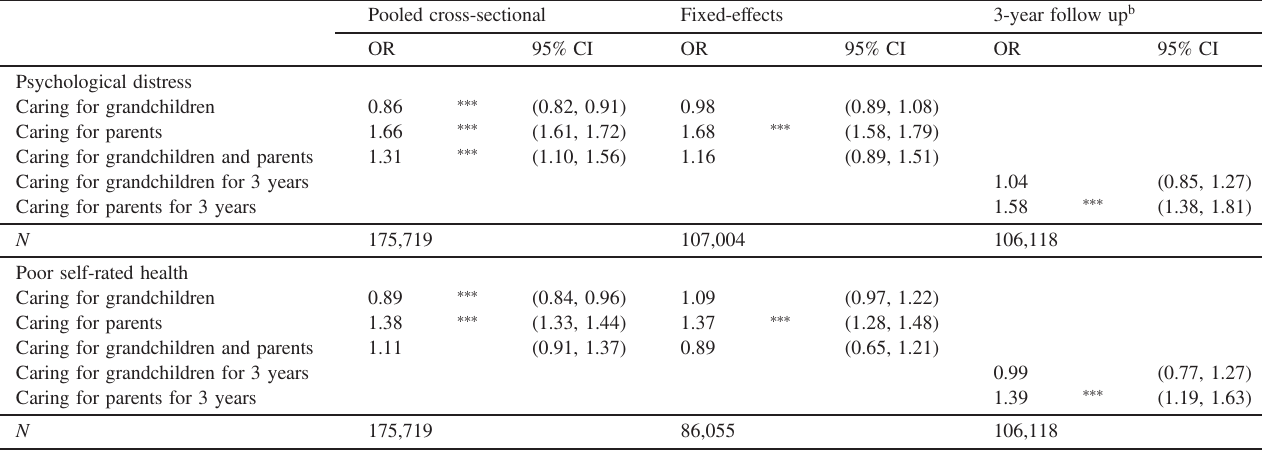
Table 3. Estimated associations of cares for grandchildren and parents with health for women a